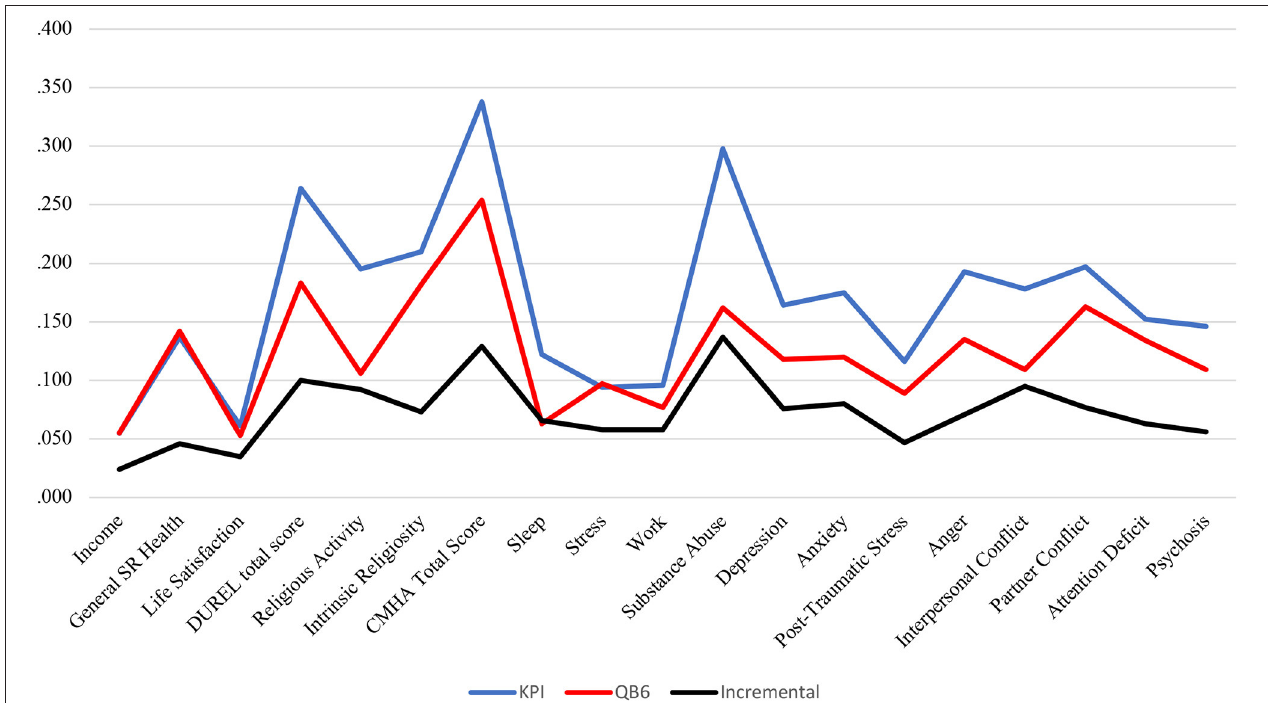
FIGURE 1 | Comparative Change in R 2 for KPI and QB6 in Predicting Criterion Variables, Accounting for Age and Gender. Duke Religion Index (DUREL); Cascades Mental Health Assessment (CMHA). Incremental = age, Gender, and all QB6 Scales Entered at Step one, KPI Scales at Step